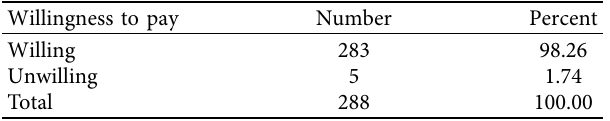
Table 3: Respondents’ willingness-to-pay for the proposed sus- tainable irrigation